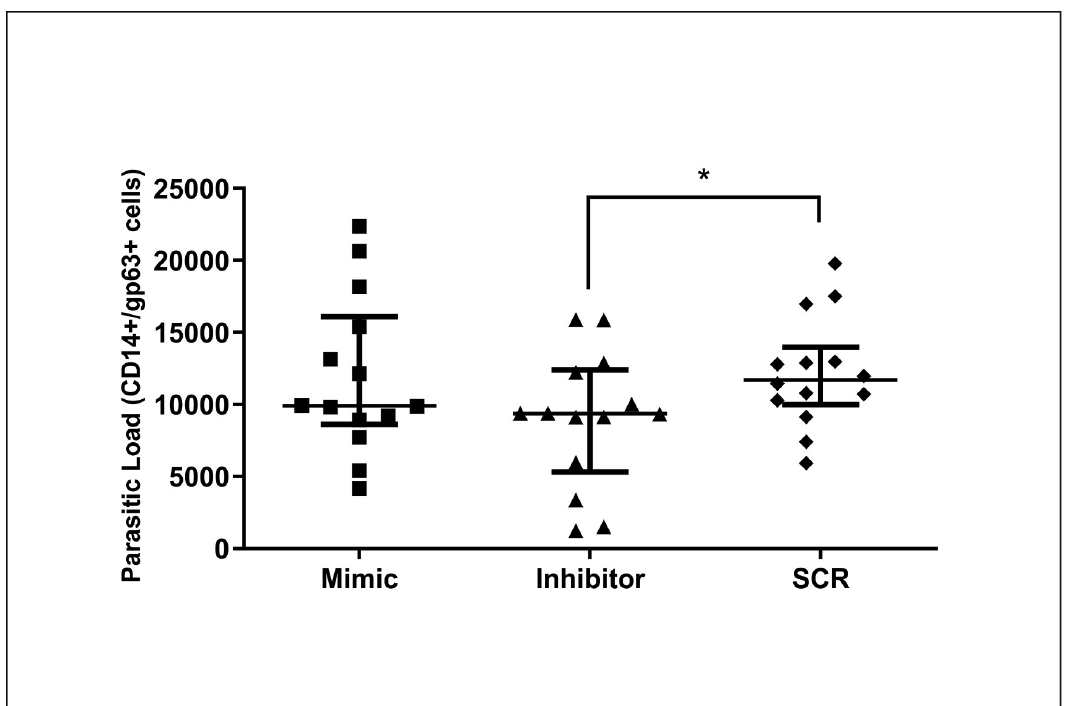
Fig 6. Parasitic load of SL. The parasitic load was quantified in splenic leukocyte cultures of dogs naturally infected by L . infantum and transfected with miR-148a mimic, miR-148a inhibitor, and SCR transfection control in the presence of Hiperfect following 48 h in the culture at 37˚C and 5% CO 2 . Bars represent parasitic load median values (9904, 9357 and 11707), 25th (8623, 5323 and 9992) and 75 th (16086, 12380 and 13975) percentile interquartile range of mimic, inhibitor and SCR treatments respectively. Symbols represent data from individual animals. Asterisks represent significant differences (Friedman with Dunn’s multiple comparison test, p = 0.02).